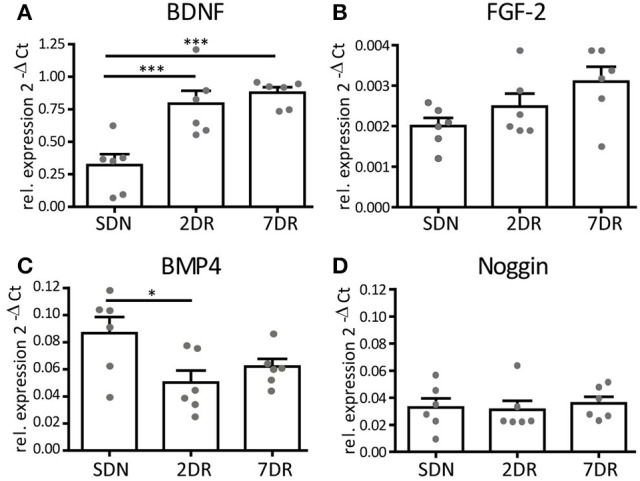
Neurogenic factors show a differential expression profile after short running periods. RT-qPCR analysis for neurogenic factors given as 2−ΔCt values relative to the house-keeping gene s12 (N = 6 mice per group, values given as mean ± SEM). (A) RT-qPCR analysis for BDNF reveals an early increase in BDNF mRNA expression in the 2DR group that persists in the 7DR group (p < 0.001 2DR vs. SDN and 7DR vs. SDN, respectively). (B) RT-qPCR analysis for FGF-2 shows a trend toward increasing expression, yet this did not reach significance. (C) RT-qPCR for BMP4 shows a decreased expression in the 2DR group compared to the SDN group (p < 0.05) but no effect for the 7DR group. (D) The expression of the BMP-antagonist Noggin is unaffected by running.